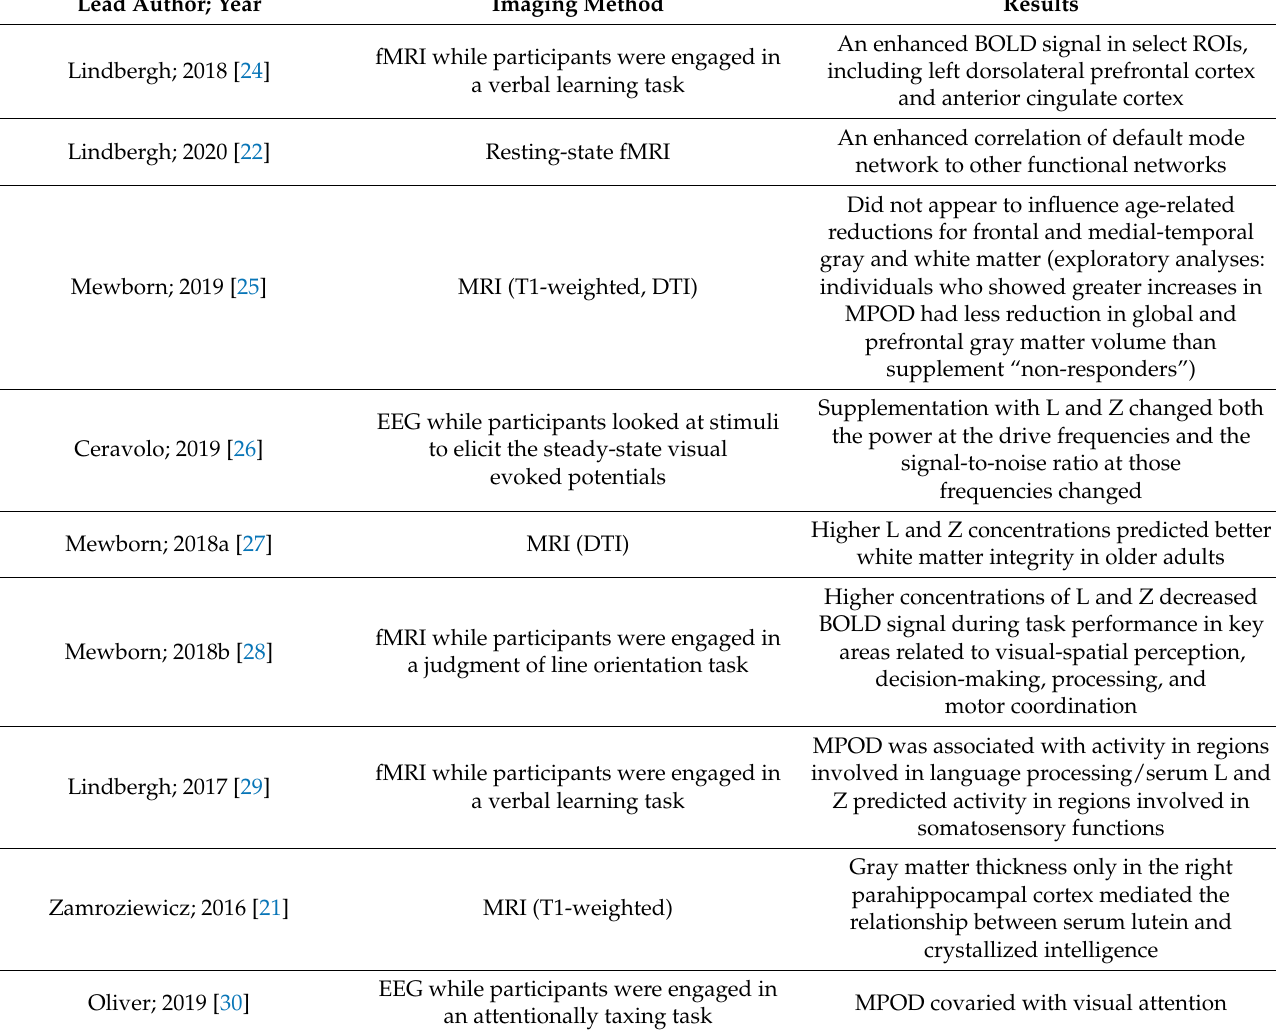
Table 3. Description of correlation between lutein or carotenoid and brain